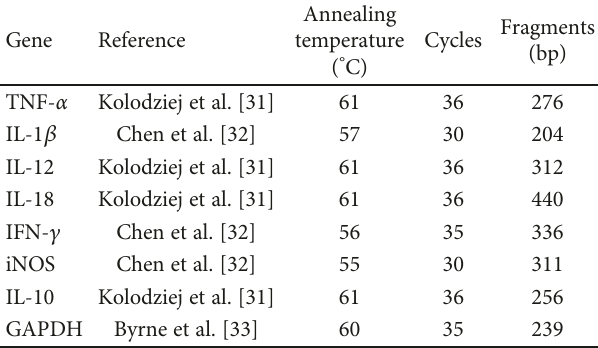
Table 1: Gene and PCR